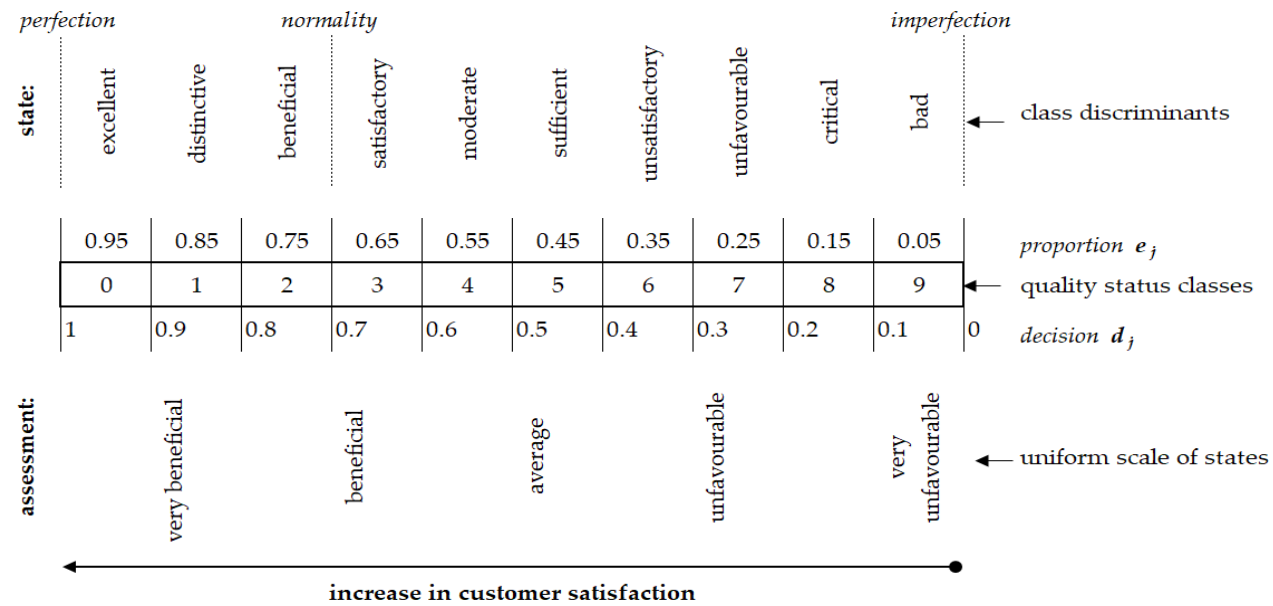
Figure 3. Relative state scale. Own study based on [17,22,30,31,36].